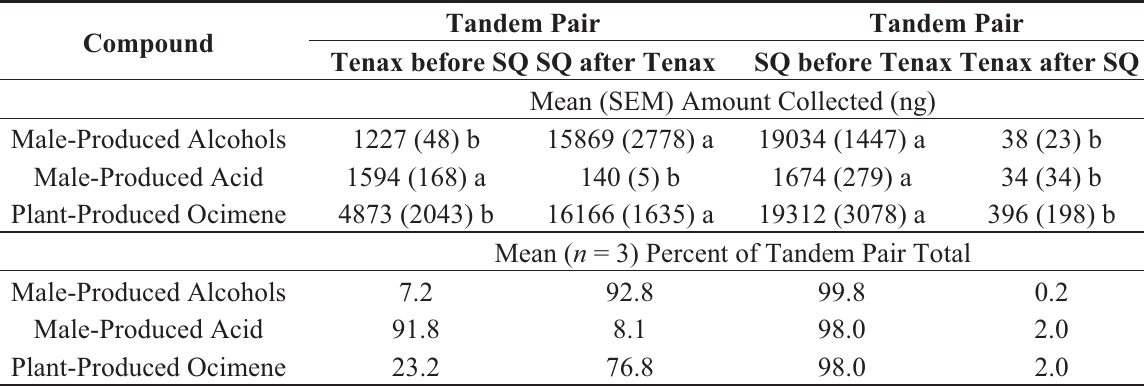
Table 1. Comparison of effectiveness of porous polymers for collecting volatiles a . Super Q is represented by SQ.